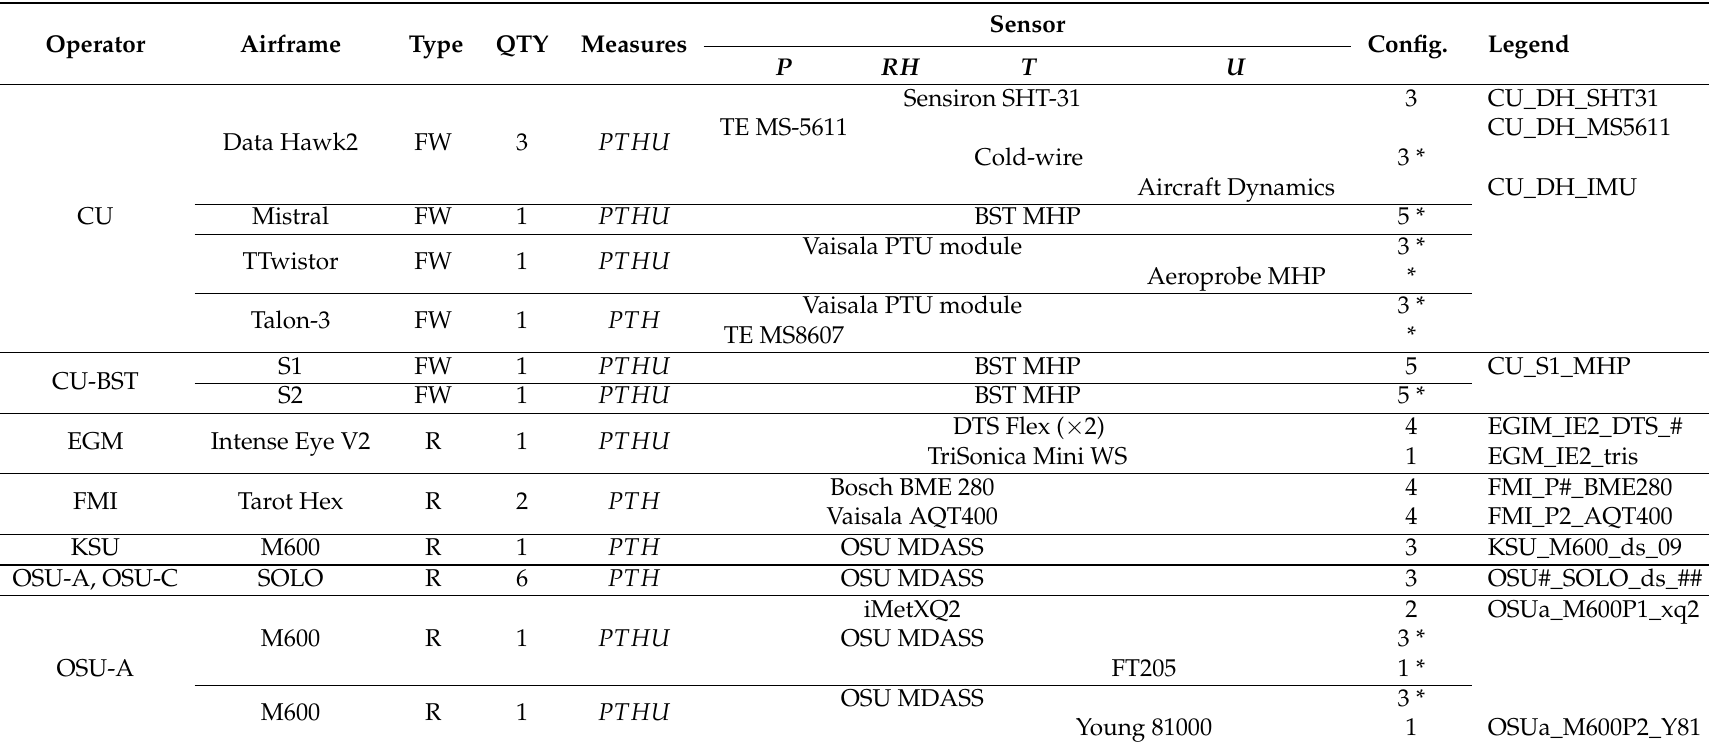
Table 1. Aircraft participating in intercomparison experiment.Operators were: CU, University of Colorado-Boulder; CU-BST, University of Colorado-Boulder and Black Swift Technologies; EGM, EngeniusMicro LLC; FMI, Finnish Meteorological Institute; KSU, Kansas State University; OSU-A, Oklahoma State University Team A; OSU-B, Oklahoma State University Team B; OSU-C, Oklahoma State University Team C; OU, University of Oklahoma; UNL, University of Nebraska–Lincoln; UKY, University of Kentucky; VT, Virginia Tech; UVA, University of Virginia. Nomenclature in table includes: R, multirotor; FW, fixed-wing; P , pressure; T , temperature; RH humidity; U , wind velocity; MHP, multi-hole probe. Configuration types refer to the configuration of the temperature and humidity sensors and are: 1—sensor packages where aspiration and solar shielding are not relevant; 2—no special sensor placement, aspiration, radiation protection; 3—sensors have aspiration and solar shielding; 4—sensors have solar shielding but no forced aspiration; 5—sensors have aspiration but no solar shielding; *—indicates data not available at time of manuscript preparation; # - indicates where numbers used in figure legends to denote different aircraft or sensors as